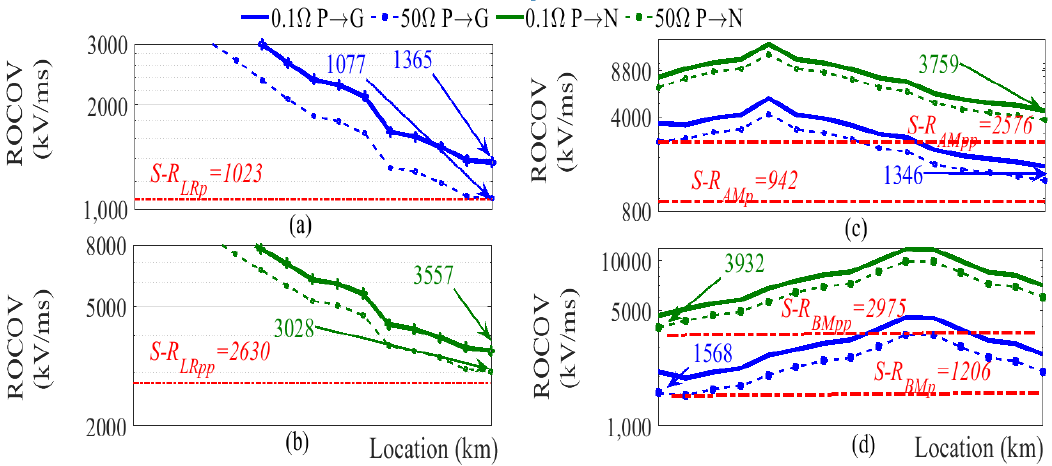
Figure 8. Calculated maximum ROCOV values ( a ) At IED-LR for P-pole-to-ground faults, ( b ) At IED-LR for P-pole-to-N-pole faults, ( c ) At IED-AM, ( d ) At IED-BM. The discrimination margin for end of line faults is higher for pole-to-pole faults (15%) when compared with the single pole-to-ground faults (5%). If a higher margin is desired for single-pole-to-ground faults, the fault resistance considered in measurement of 𝑅𝑂𝐶𝑂𝑉 𝑝𝑀𝑥_𝐵 that is used in Equation (4) can be lowered, leaving the end of line high resistance faults to be dealt using a transfer trip scheme or a line differential type backup protection scheme. Clearing time is not critical for such faults as the current rises slower and the peak fault current is lower for remote high resistance faults. As depicted in Figure 7, pole(s) involved in the fault can be identified using F PN with an adequate